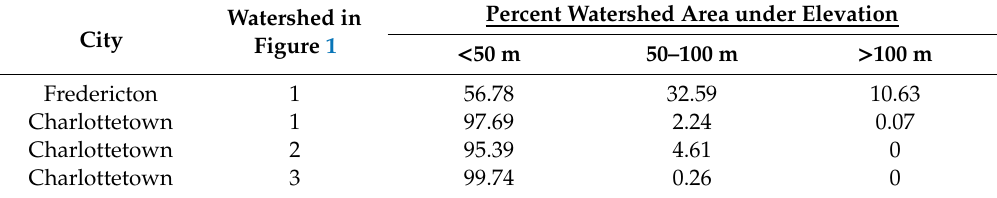
Table 6. Topographical characteristics of the watersheds of Fredericton and Charlottetown (displayed in Figure 1) retrieved from flood hazards analysis using ArcSWAT (Soil and Water Assessment Tool) interfaced with ArchGIS.